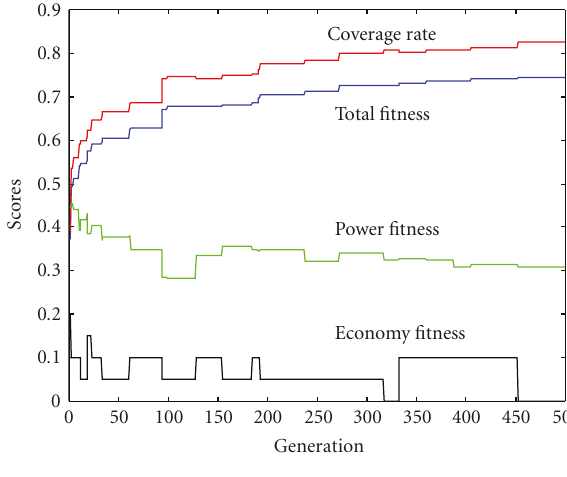
Figure 20: Fitness value, ( ω t , ω p , ω e ) = (0 . 9,0 . 0,0 . 1).